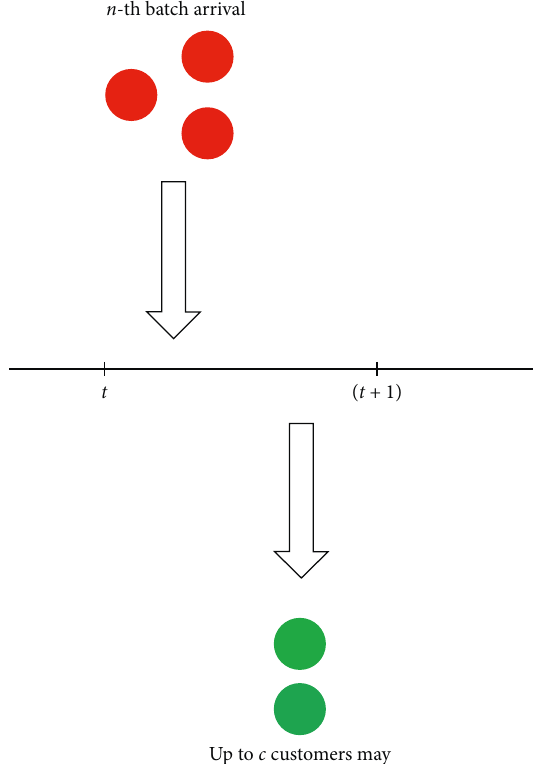
Figure 1: GI X / Geo / c with